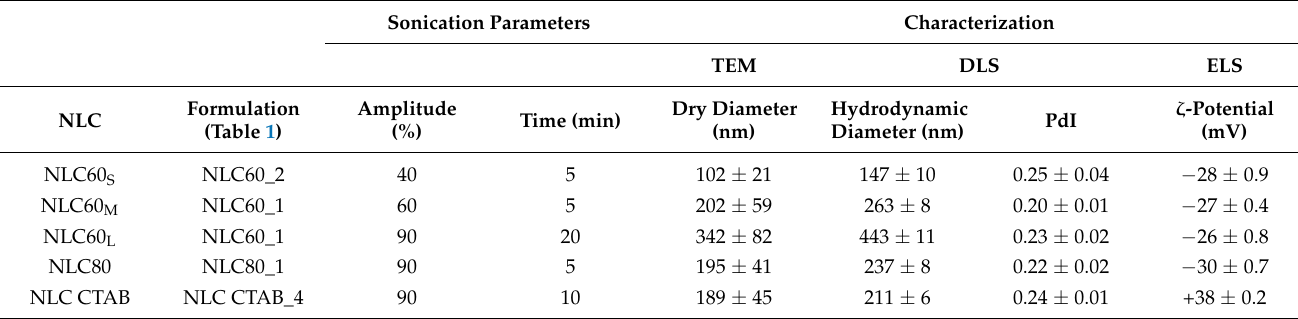
Table 2. NLC formulations chosen for the in vitro assays with different bacteria. Final optimized sonication parameters and characterization by dynamic light scattering (DLS) and electrophoretic light scattering (ELS). Data are expressed as means ± standard